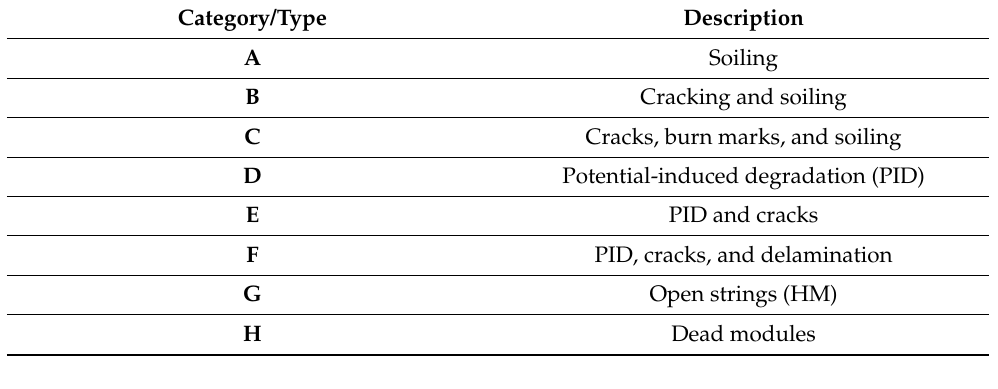
Table 2. Categories of CIGS PV module faults.